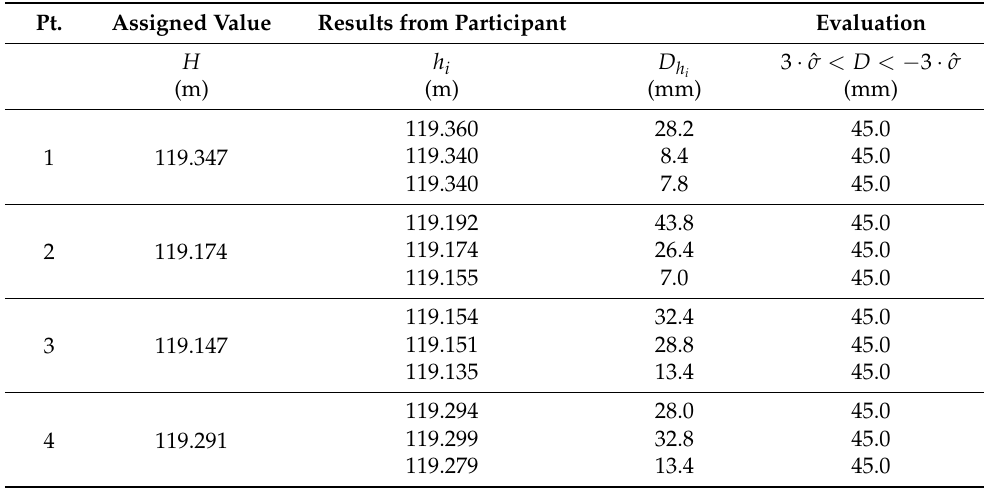
Table 4. Bias D for the height h ( i = AGROS; “Vekom Net”; “GentooARS”). Pt. Assigned Value Results from Participant Evaluation